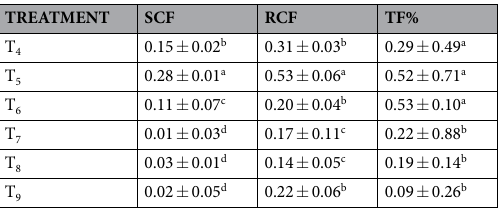
Table 1. Concentrations of polycyclic aromatic hydrocarbons (PAHs) in plant tissues, shoot/root concentration factors (SCFs/RCFs), and the root-to-shoot transfer factors (TFs) are influenced by cadmium, PAHs, and the interaction between the two after 60 days of growth in Acorus calamus . Values (means ± SE, n = 3) followed by the same letter within columns are not significantly different according to the least significant difference test (p < 0.05). Treatments: C1P0 (T 4 ), C1P1 (T 5 ), C1P2 (T 6 ), C2P0 (T 7 ), C2P1 (T 8 ), and C2P2 (T 9 ). C0, C1, and C2 represent 0, 10, and 20 mg Cd kg − 1 ; P0, P1, and P2 represent 0, 50 + 25, and 100 + 50 mg PAHs kg − 1 with PHN + PYR,